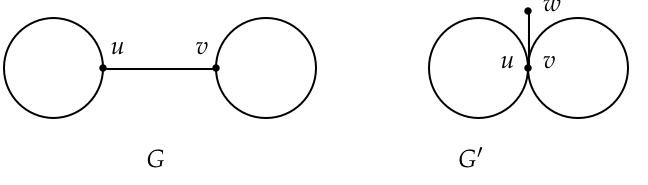
Figure 1. Graphs G and G (cid:48)